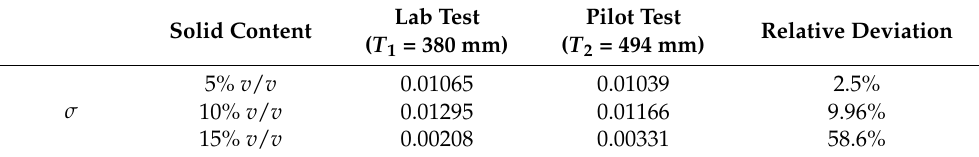
Table 4. The solid uniformity σ before and after scaling up based on the same blade tip speed. Solid Content